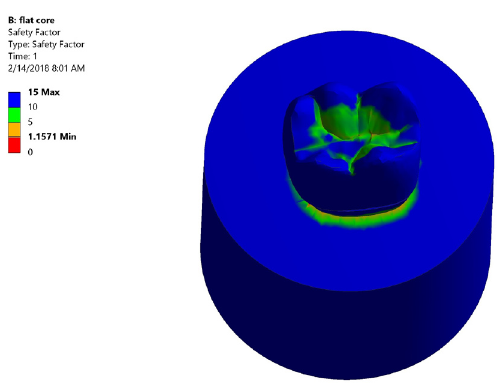
II.Figure 8. Color graphics showing total deformation of Group I.